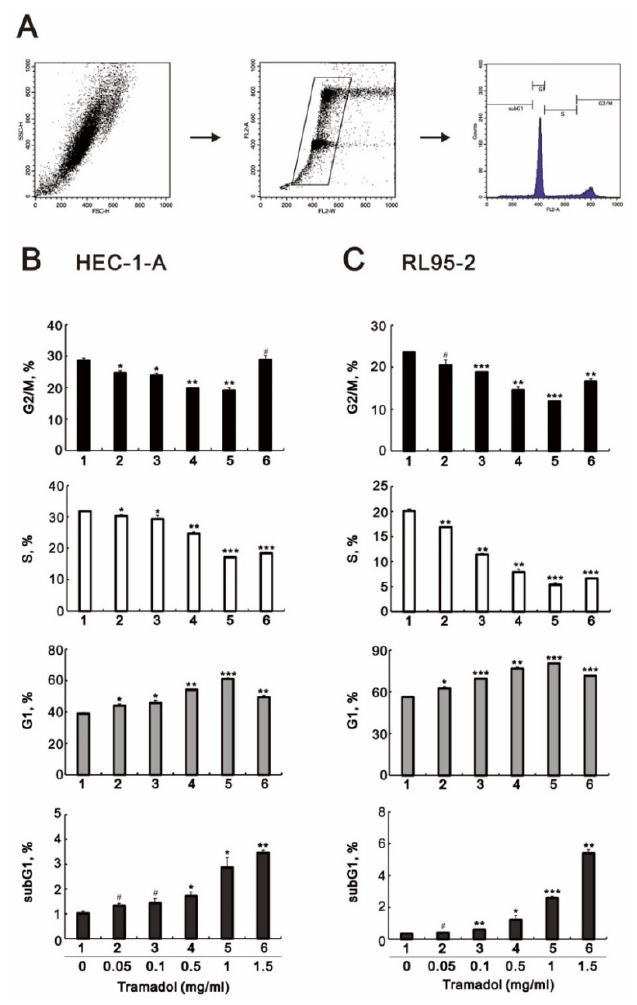
Figure 2. Effects of tramadol on the cell cycle of human endometrial cancer cells. ( A ) Representative images of individualized gating strategies for different cell cycle phases using PI staining ( B , C ) HEC-1-A and RL95-2 cells were treated with tramadol (0, 0.05, 0.1, 0.5, 1, and 1.5 mg/mL) for 24 h. Cells were stained with propidium iodide (PI) and analyzed using flow cytometry. Bars depict the mean ± SD of three independent experiments. Student’s t -tests were performed and the results were compared with the vehicle. # p > 0.05, * p < 0.05, ** p < 0.01, and *** p < 0.001 (Student’s t